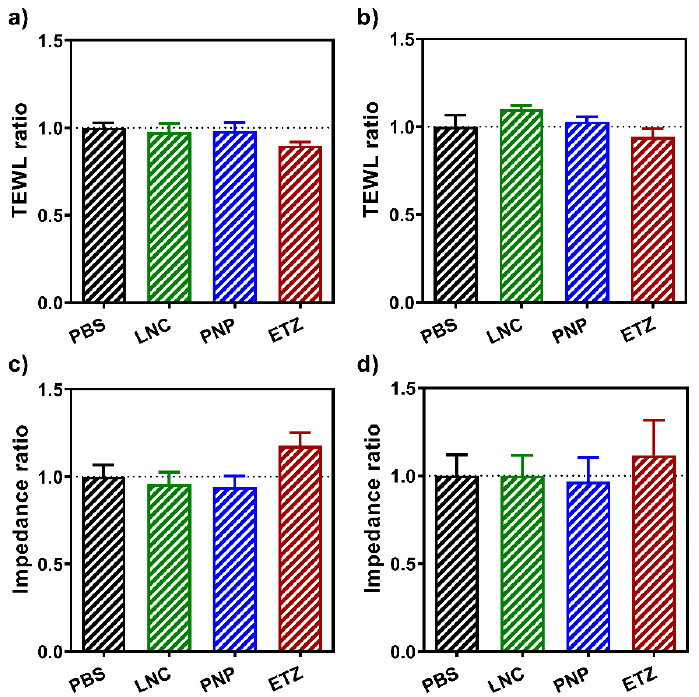
Figure 6. TEWL and impedance ratios of values obtained before and after the application of the respective nanoformulation (LNC, ETZ, PNP) or control (PBS) on ( a,c ) the porcine skin, ( b,d ) the human skin. n ≥